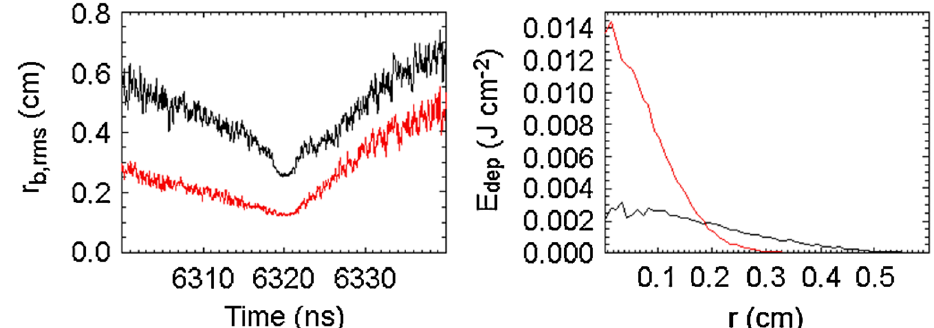
(cid:9) t (cid:10) (left) and radial profiles of cumulative E (cid:9) r (cid:10) from the main pulse from t (cid:6) b dep (cid:6) (cid:1) 32 : 3 mrad , and the dynamic ferroelectric plasma simulation for r